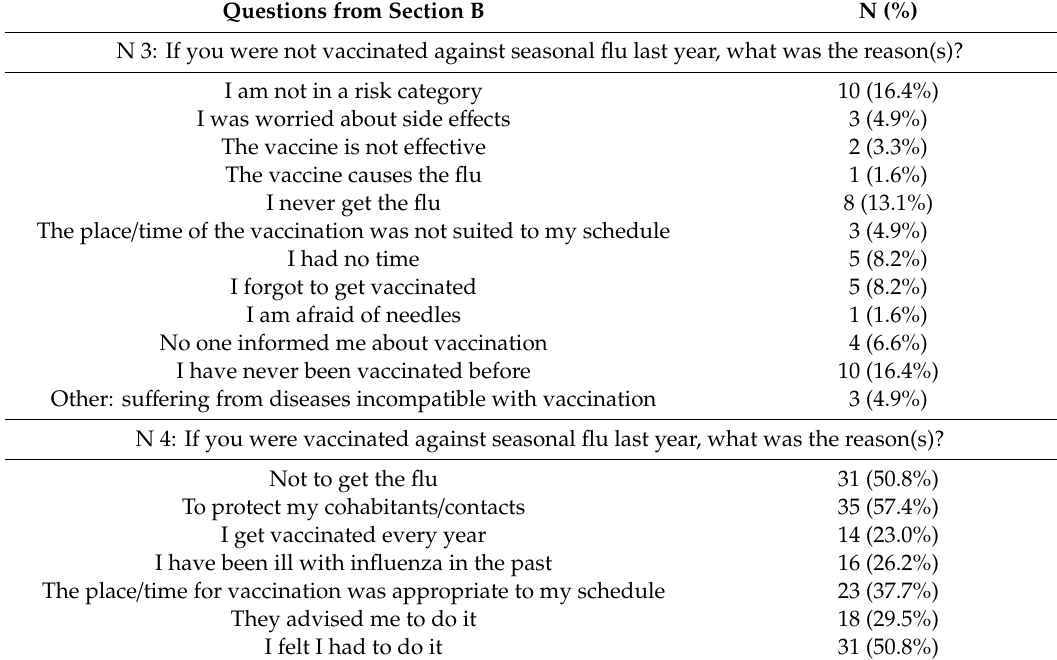
Table 4. Sample’s answers to questions 3–9 from section B of the questionnaire.